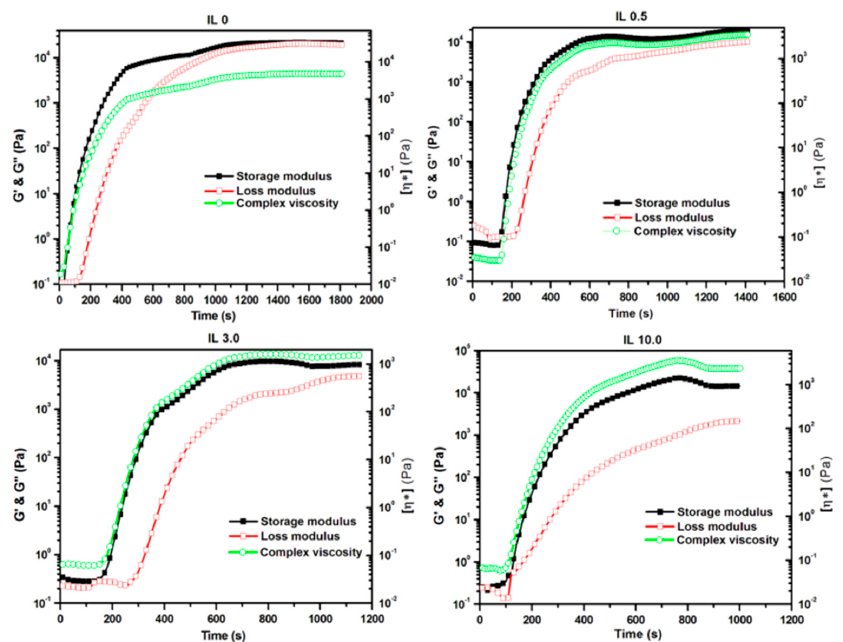
Figure 3. Time-dependent rheological studies of storage modulus (G’), loss modulus (G”), and complex viscosity ( η *) for the silica sols prepared using ionic